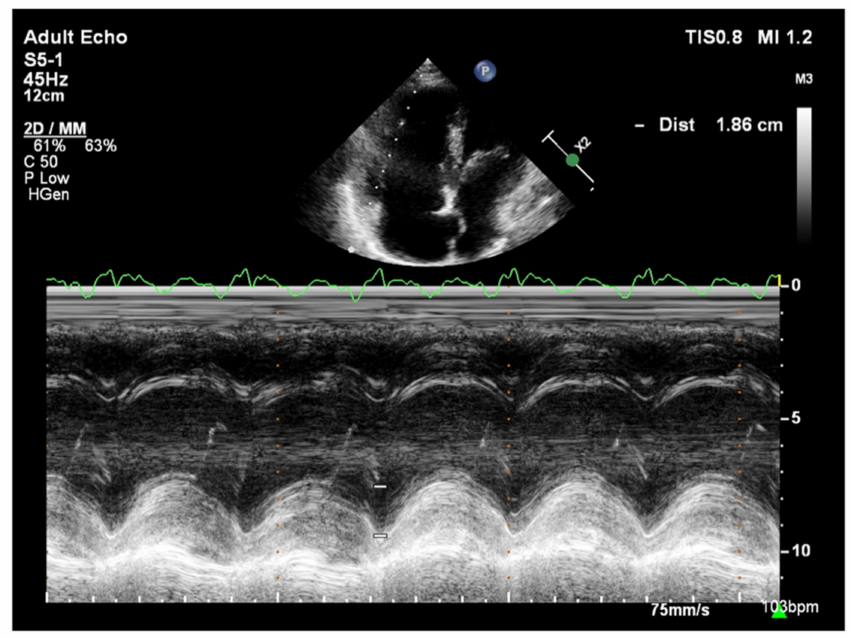
Figure 8. Patient with PAH, TAPSE = 1.86 cm. TTE, M-mode. PAH: pulmonary arterial hypertension; TAPSE: tricuspid annular plane systolic excursion; TTE: transthoracic echocardiography.